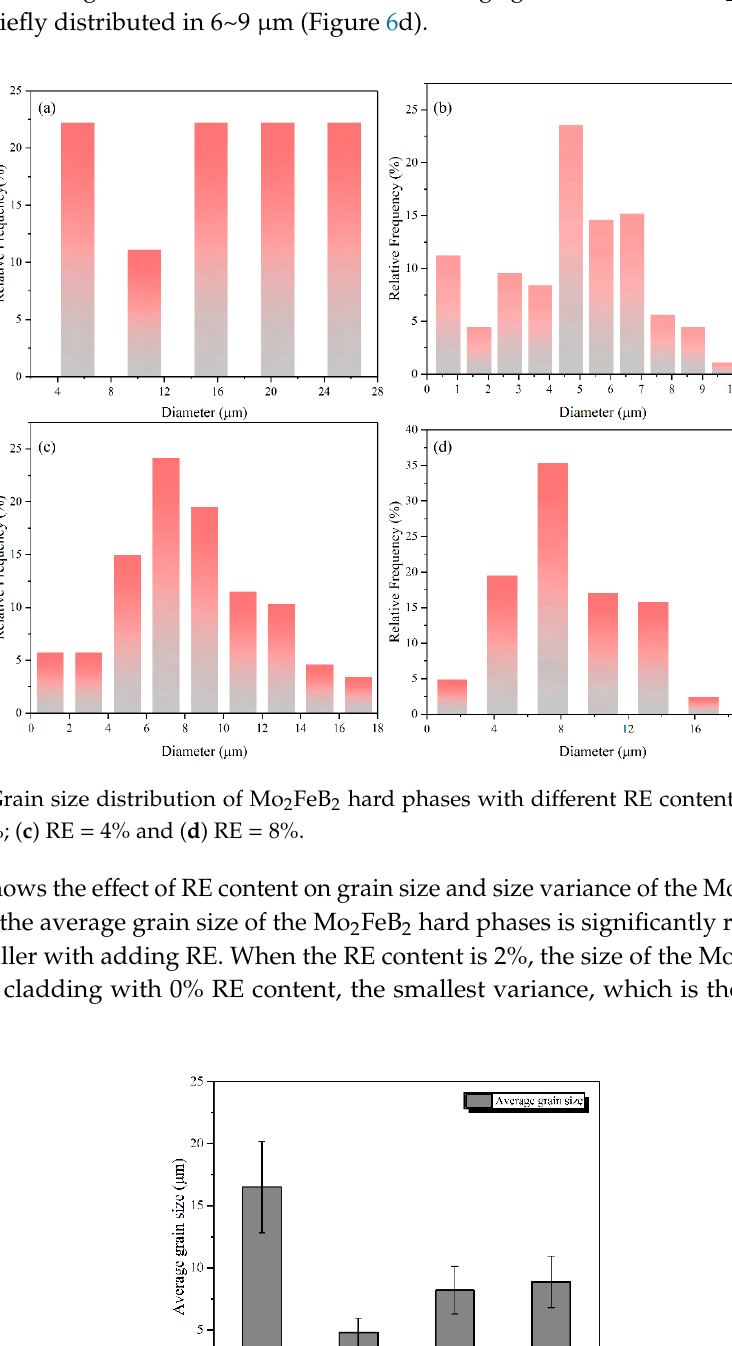
Figure 7. Average grain size of Mo 2 FeB 2 hard phases with different RE contents.